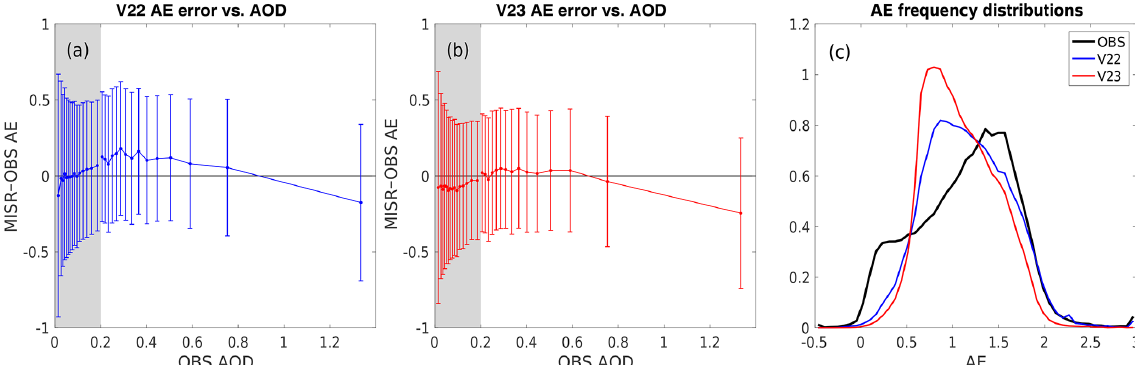
Figure 17. V22 and V23 AE comparisons against AERONET + MAN observations (OBS). (a) AE difference (MISR V22 – OBS) as a function of OBS AOD; data are split into two AOD regimes, OBS AOD ≤ 0 . 2 and OBS AOD > 0 . 2, and divided into 15 equally populated bins within each of the AOD regimes. The shaded area marks the smaller AOD regime. The markers represent the median AE difference values within each AOD bin and the error bars are 1 standard deviation of AE difference within each bin. (b) is the same as (a) but for the MISR V23–OBS AE difference. (c) Normalized frequency distributions of AE obtained from the three collocated data sets. The total number of analyzed collocations is 61015, and 17027 of collocations have OBS AOD > 0 . 2.